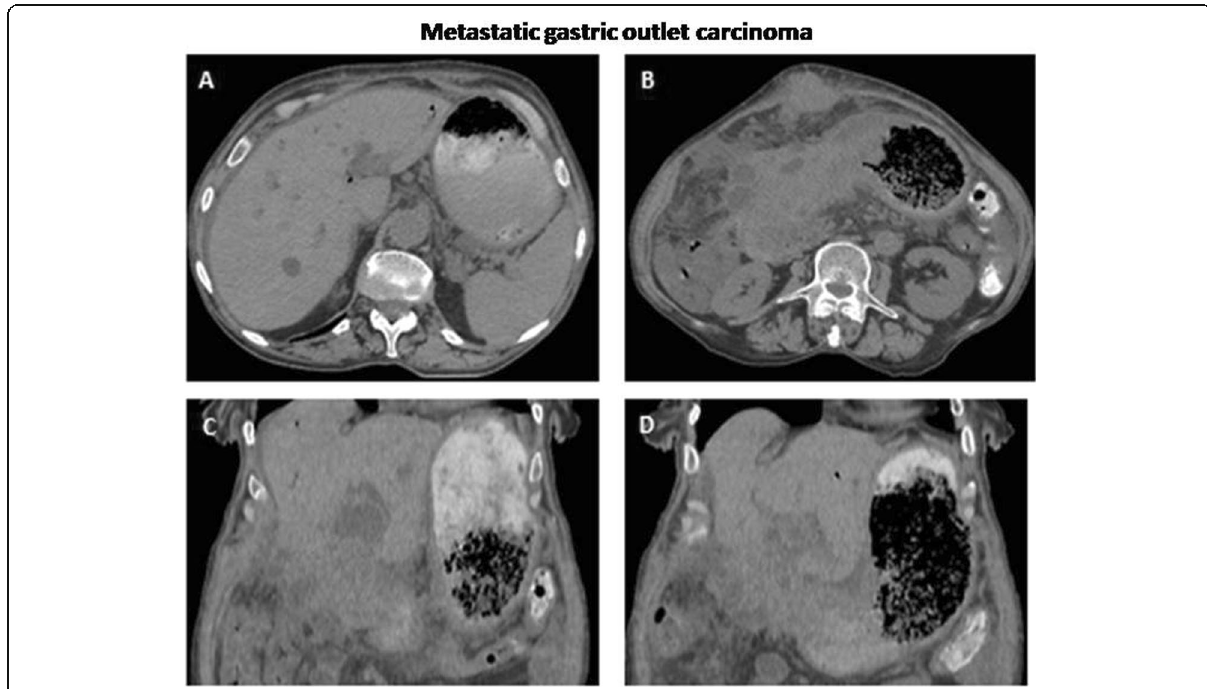
Fig. 5 Metastatic gastric outlet carcinoma. Malignant obstructive jaundice caused by gastric outlet carcinoma (pathologically proved) exerting mild intra-hepatic biliary radical dilatation. Female patient, 69 years old, presented with progressive jaundice, abdominal swellings, vomiting, and cachexia. a Axial post-oral contrast image shows minimal intrahepatic biliary radicle dilatation; also, an anterior abdominal wall solid mass lesion is noted. b Axial post-oral contrast image shows diffuse irregular gastric outlet abnormal wall thickening forming gastric outlet focal mass seen encroaching upon contrast filled lumen and exerting proximal gastric dilatation. c , d Coronal reformatted MDCT cholangiography images showing obliterated related fat planes with inferior surface of the left liver lobe with compression of the hepatic